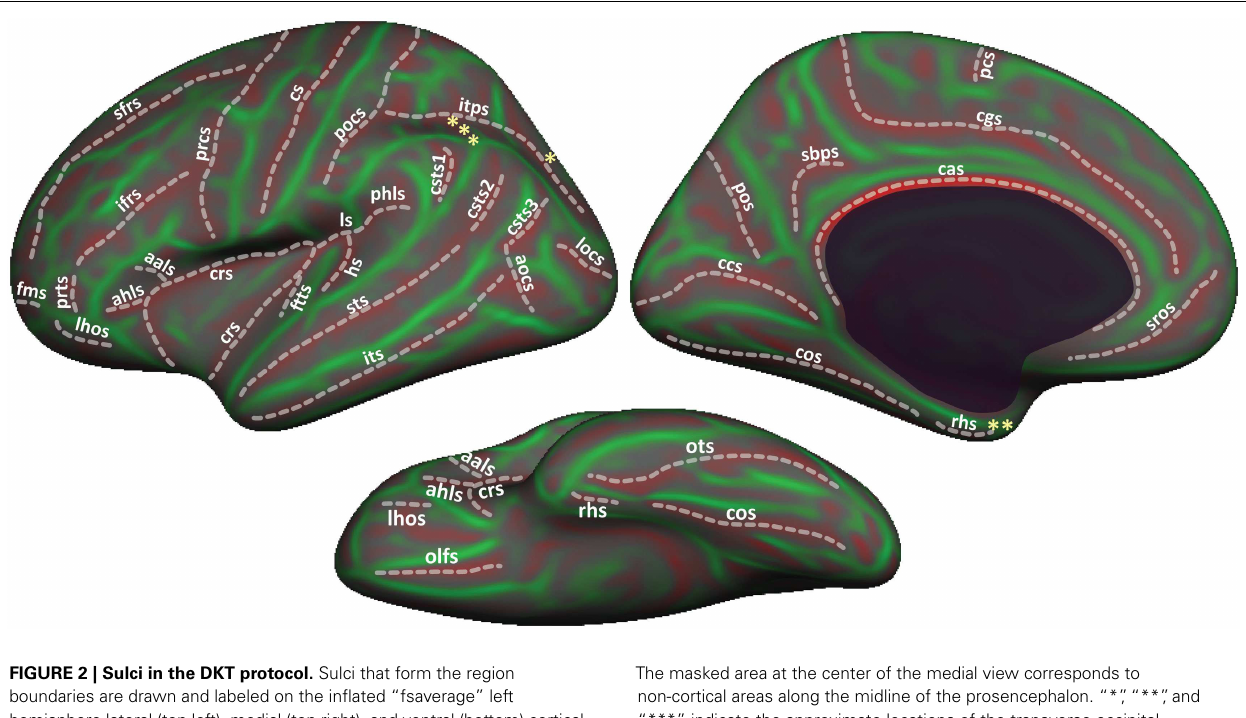
FIGURE 2 | Sulci in the DKT protocol. Sulci that form the region boundaries are drawn and labeled on the inflated “fsaverage” left hemisphere lateral (top left), medial (top right), and ventral (bottom) cortical surface. A map of surface curvature is indicated by the red-green colormap. Convex curvature corresponding to gyral crowns are shown in green; concave curvature corresponding to sulcal fundi are shown in red.